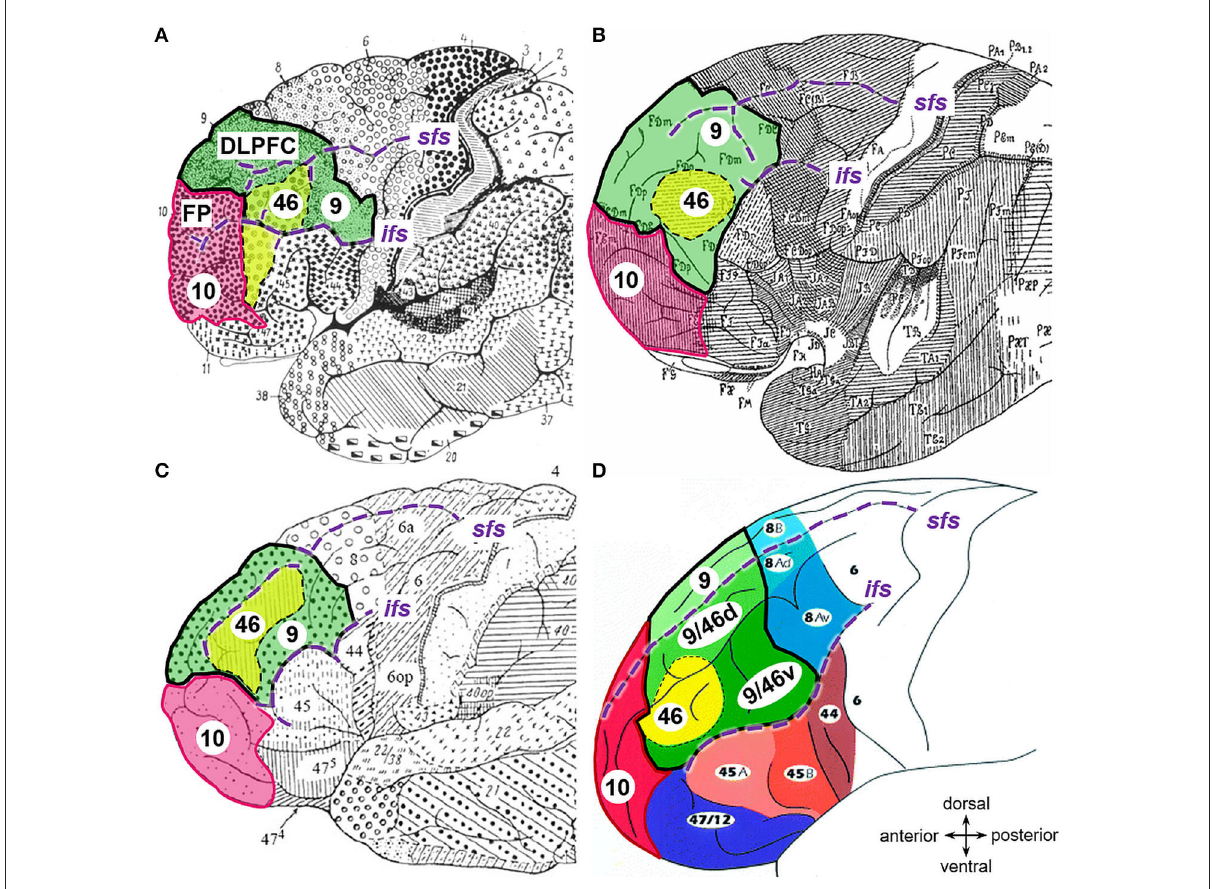
FIGURE1 Maps of the prefrontal cortex. Adapted cytoarchitectonic maps showing the dorsolateral prefrontal cortex (DLPFC, bold black lines) and frontal pole (Fp, magenta) as segmented and labeled by (A) Brodmann (1909), (B) von Economo and Koskinas (1925), (C) Sarkissov et al. (1955), and (D) Petrides and Pandya (1999) with copyright permission. Related areas are highlighted in corresponding colors: area 9 (green) and 46 (yellow) of the DLPFC and area 10 of the Fp (magenta). Sulci labeled in violet italic ( sfs , superior frontal sulcus; ifs , inferior frontal